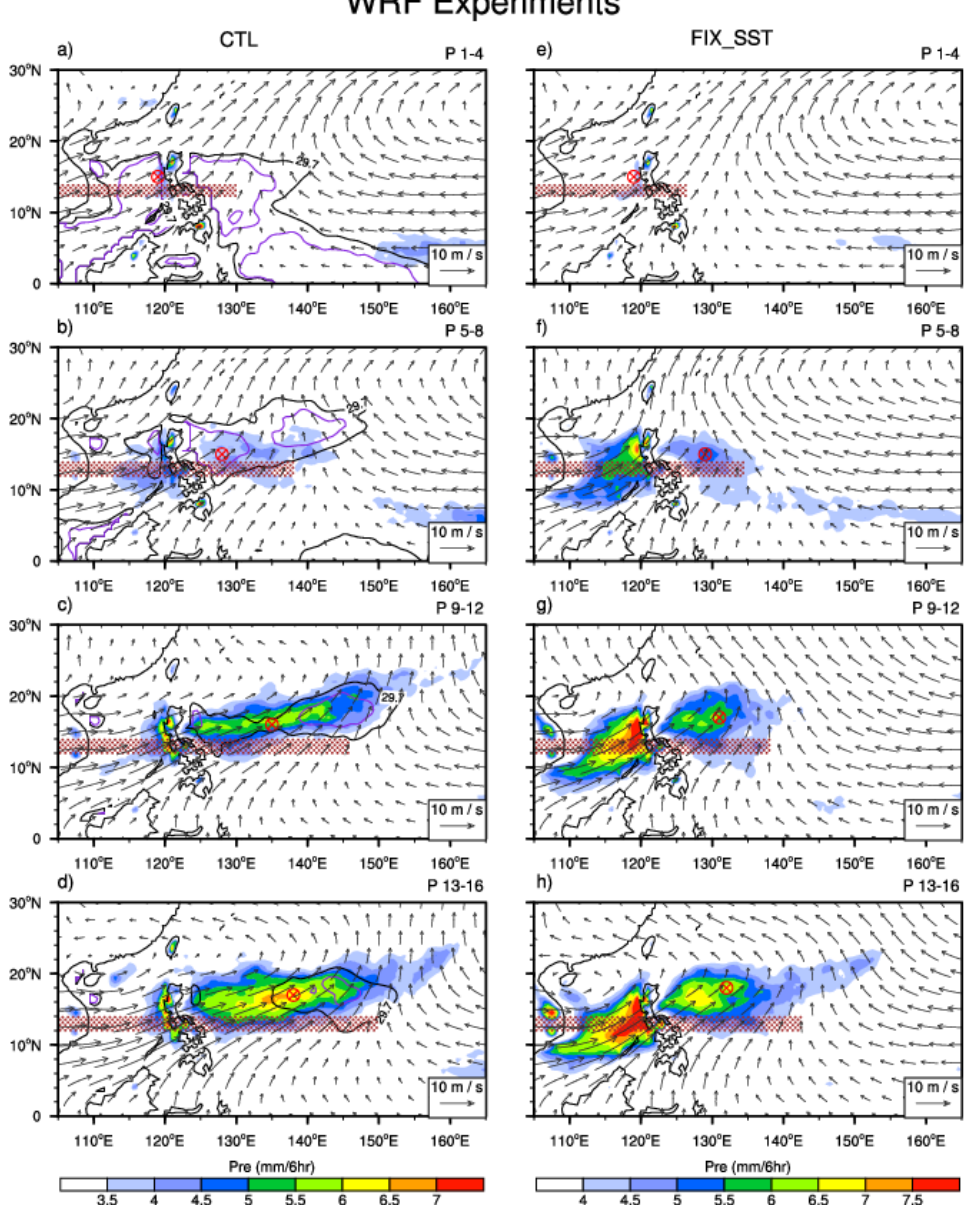
Figure 6. ( a – d ) Horizontal evolution (4 pentad mean) patterns of the precipitation (shading; mm/6 h) and 850 hPa wind (vector; ms − 1 ) fields in CTL (left panel). ( e – h ) (right panel): Same as in ( a – d ) except in FIX_SST. Contours in the left panel represent SST (unit: ◦ C), with the purple contour denoting 29.8 ◦ C. The red straps show the eastward-extended low-level westerly. Red circles denote eastward-expanding MT rainfall centers.